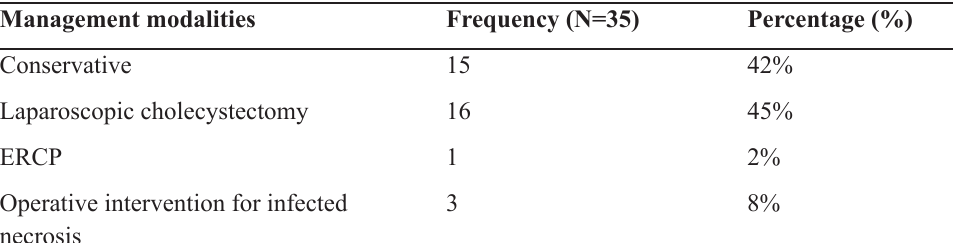
Table 2: Management of patients with AP Management modalities